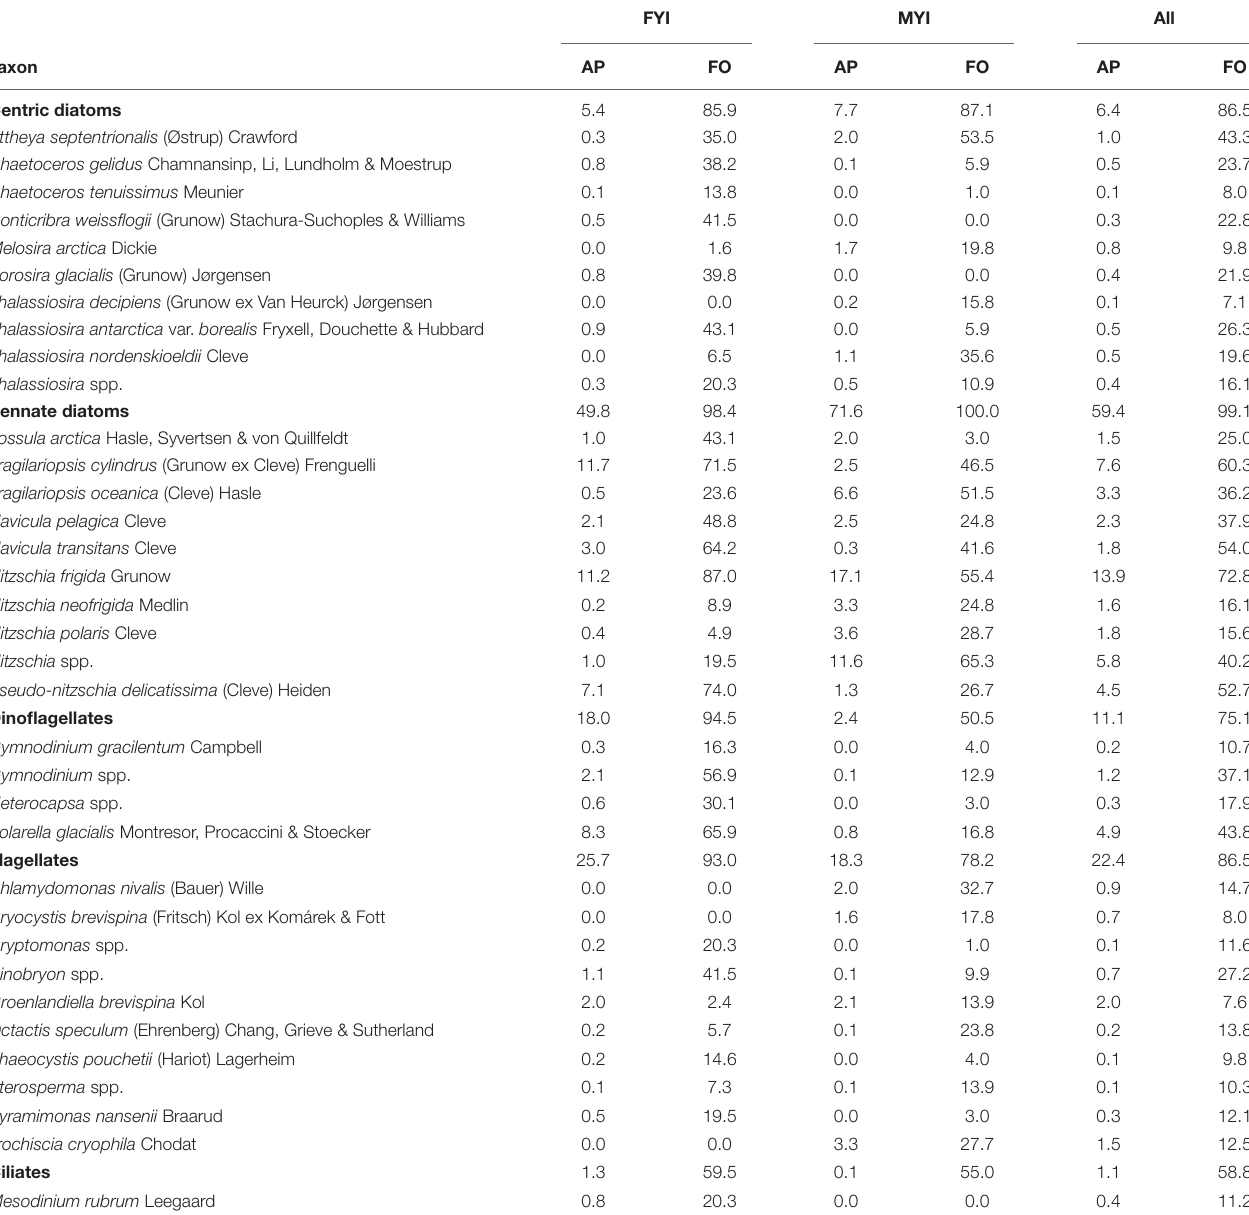
TABLE 3 | Sea-ice protists sorted by group recorded in the combined dataset for first-year ice (FYI), multiyear ice (MYI) and all samples (All). FYI MYI All AP FO